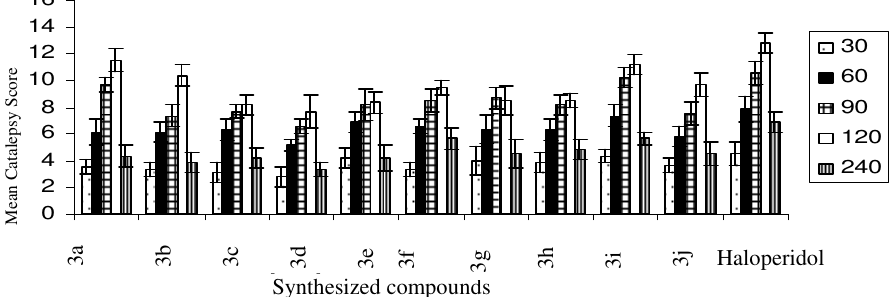
Figure 3 . The effect of synthesized compounds ( 3a-j ) on induction of catalepsy in mice. Results are expressed as the mean ±SEM. (n=6),